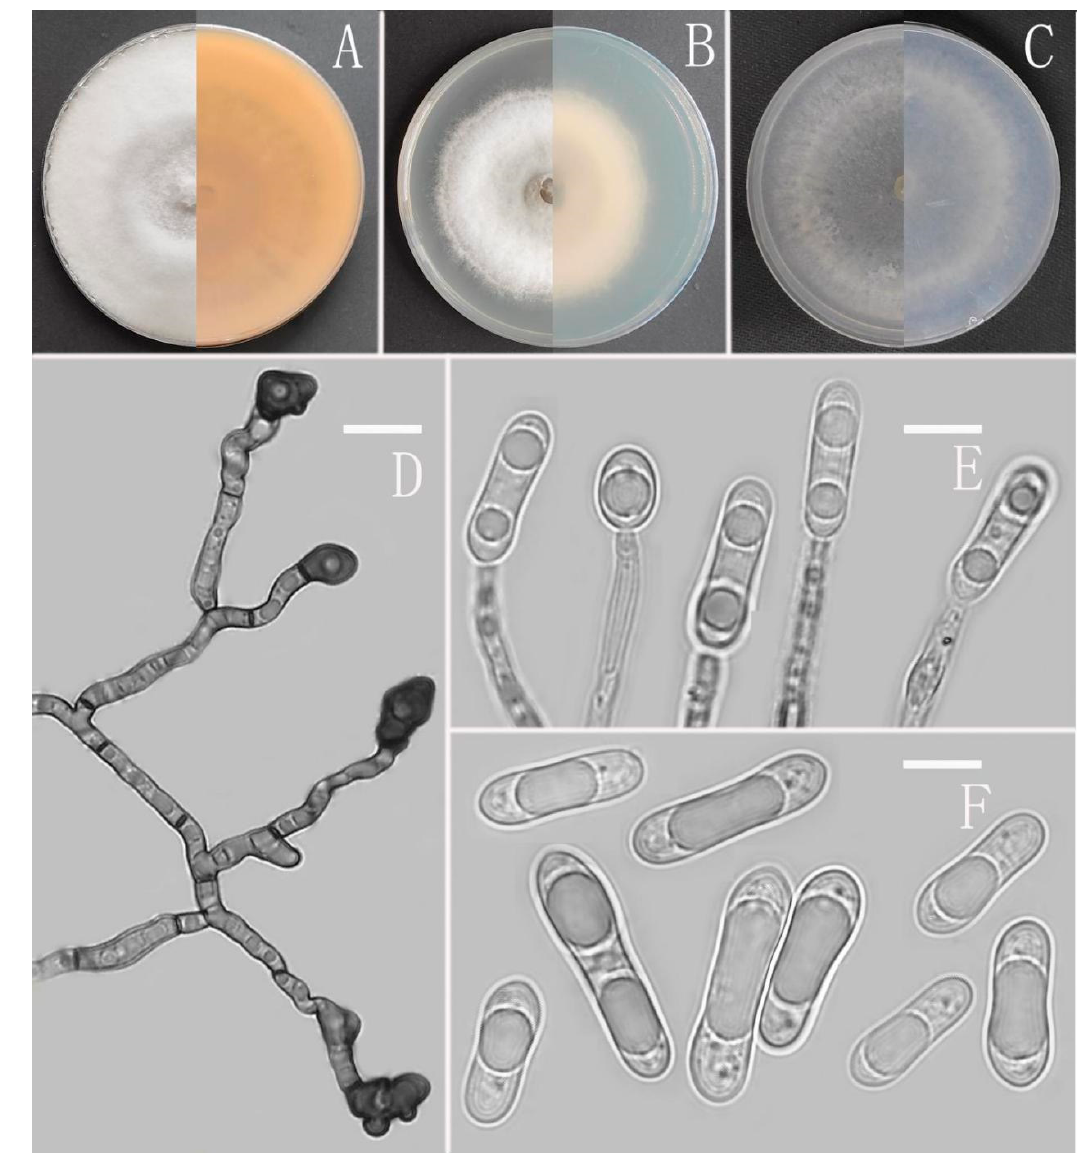
Figure 14. Colletotrichum subhenanense (YMF1.06865). ( A – C ) Colonies on media above and below after 7 d at 25 °C (( A ) MEA; ( B ) PDA; ( C ) SNA). ( D ) Appressoria. ( E ) Conidiophores. ( F ) Conidia. Scale bars: ( D – F ) = 10 μ m.